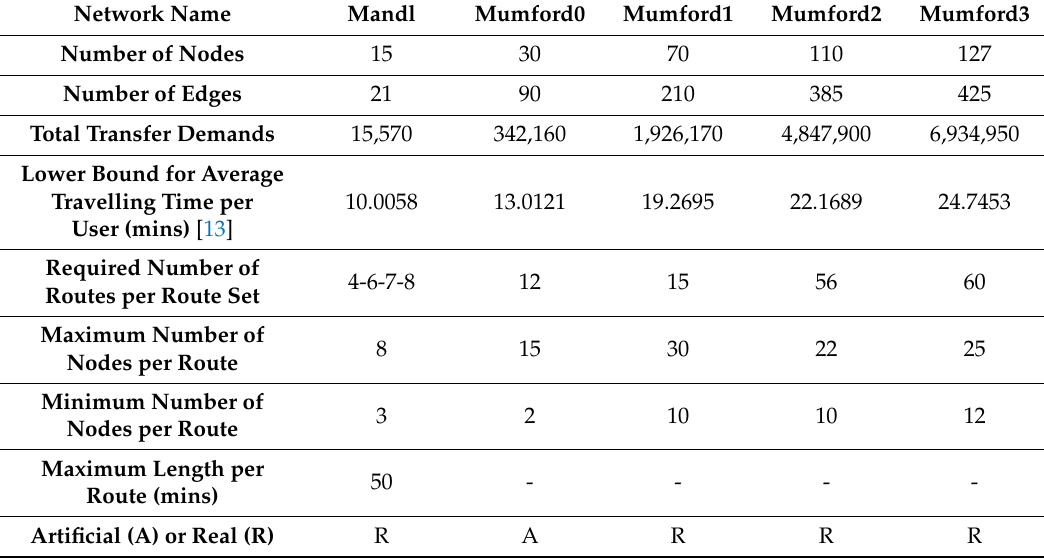
Table 4. Attributes of input instances’ road